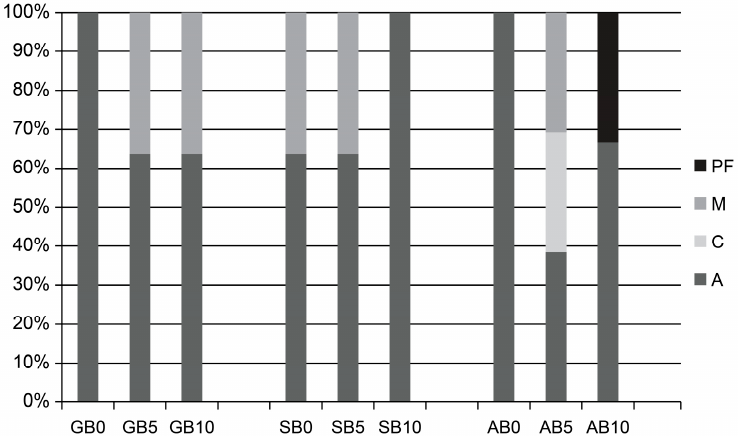
Figure 4. Distribution of the failure mode (%) in self-etch mode. GB0 : 0 s group for G-Premio Bond; GB5 : 5 s group for G-Premio Bond; GB10 : 10 s group for G-Premio Bond; SB0 : 0 s group for Single Bond Universal; SB5 : 5 s group for Single Bond Universal; SB10 : 10 s group for Single Bond Universal; AB0 : 0 s group for All Bond Universal; AB5 : 5 s group for All Bond Universal; AB10 : 10 s group for All Bond Universal. PF : premature failure; M : mixed failure; C : cohesive failure; A : adhesive failure.